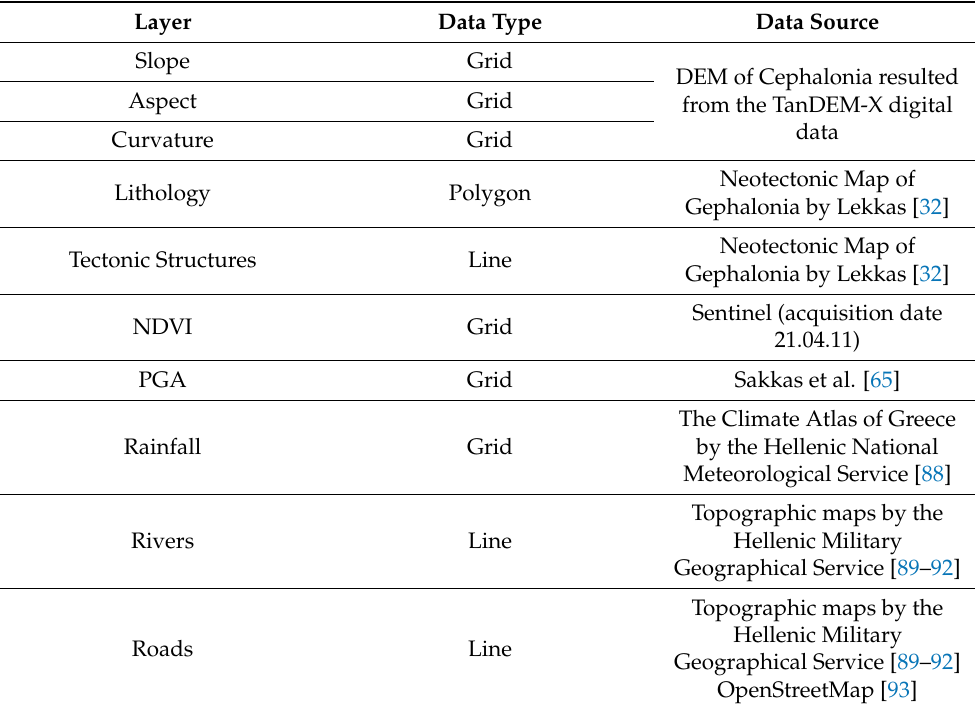
Table 3. Thematic layers used in the study and their